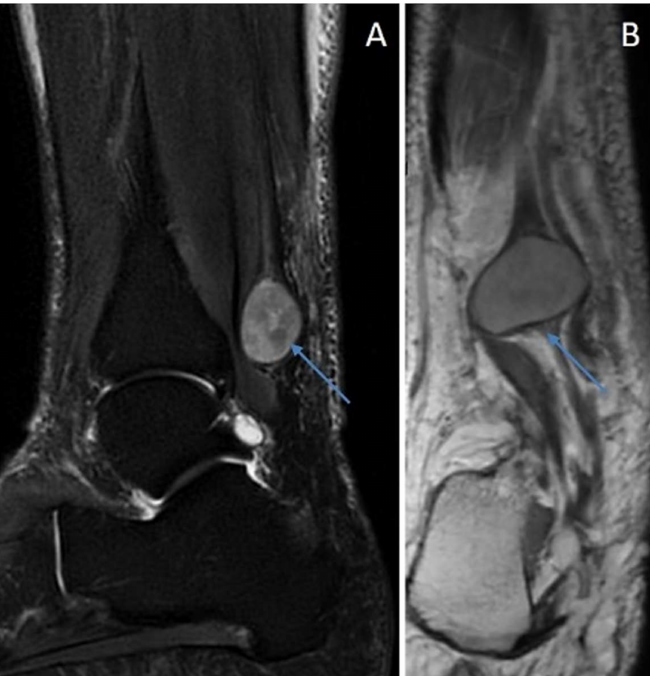
Figure 10. Solitary schwannoma: round mass (arrows) of the posterior tibial nerve. ( A ) DP fat sat sagittal view and ( B ) T1 post-enhanced sagittal view.